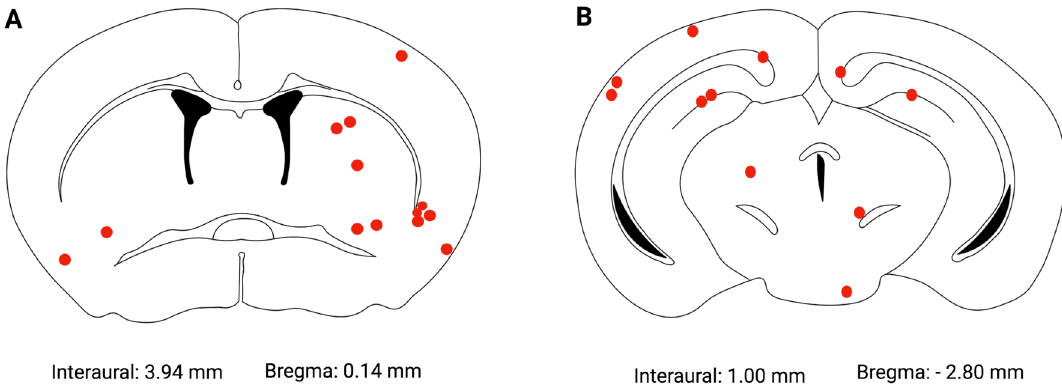
Figure 3. Representation of nanoparticle agglomerates (red dots) localization in mice brain treated with nanosystems functionalized with traceable fluorophore aluminum chloride phthalocyanine (ALNP + AlClPc